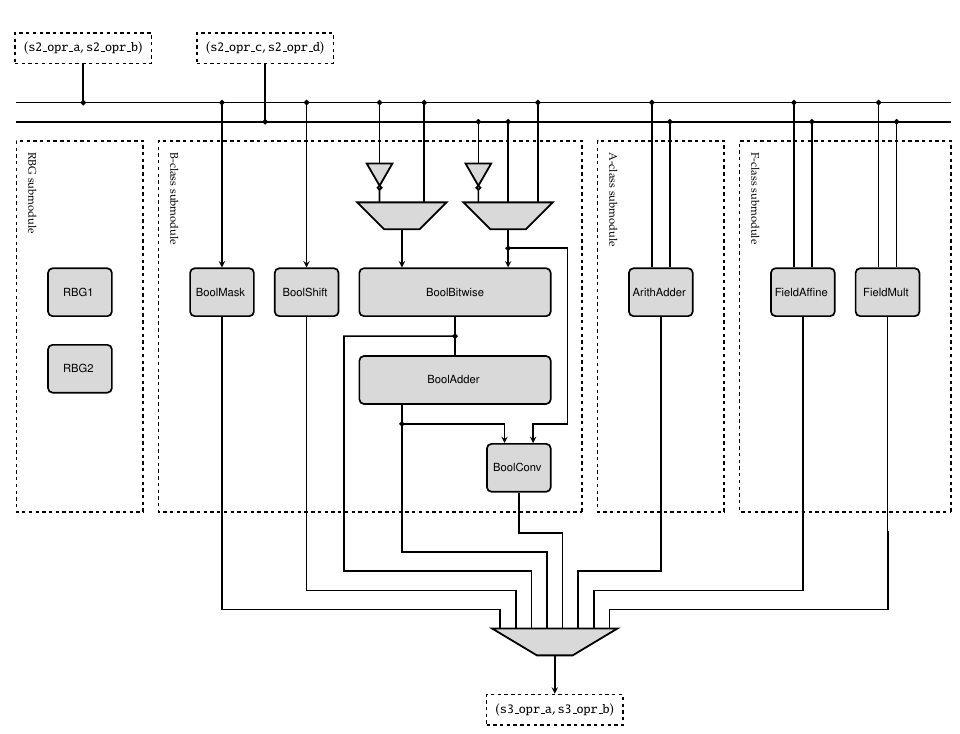
Figure 1: A block diagram illustrating submodules of the masked ALU module, and their internal organisation. Note that, for clarity, we use 2-share connections (i.e., each connection communicates two, 32-bit shares) throughout and omit all connections stemming from the two RBG instances: these are used by almost all other